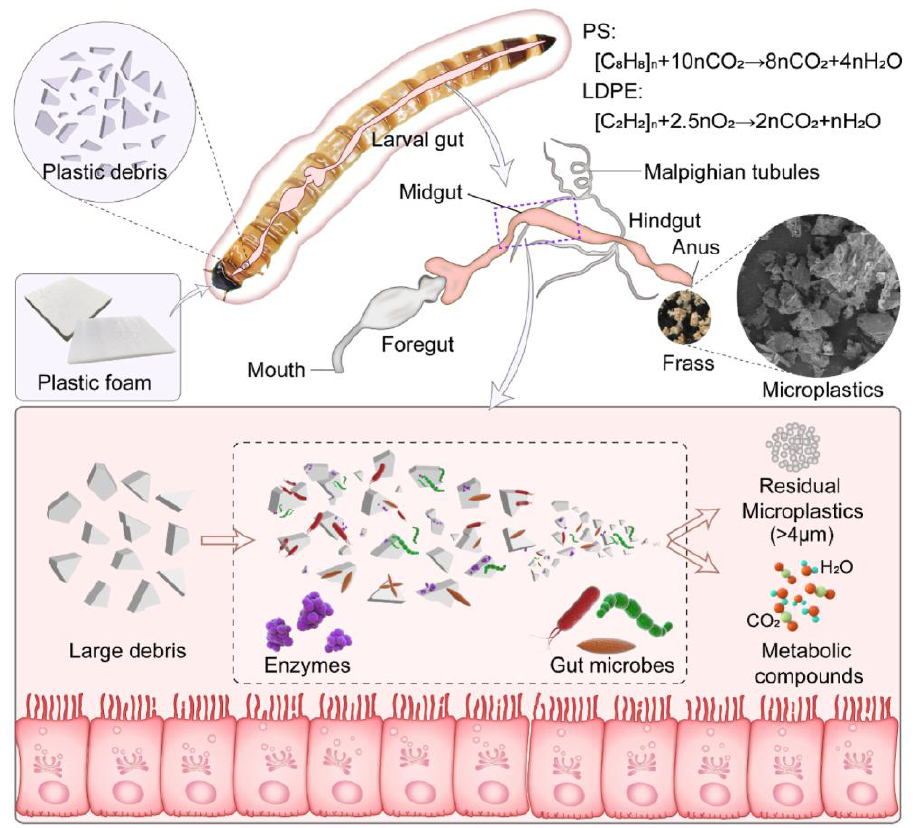
Figure 4. Conceptual schematic diagram for the biodegradation of PS and LDPE foams in Zophobas atratus larvae, reprinted with permission from [36].